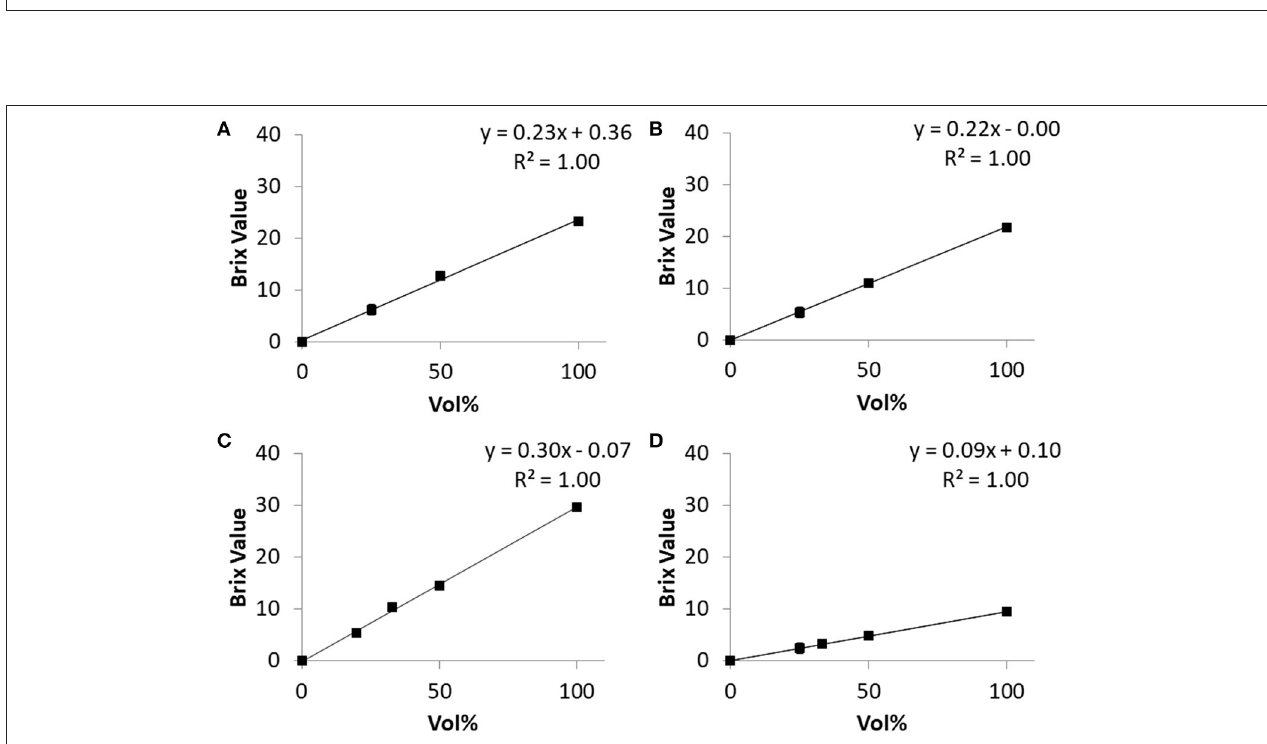
FIGURE 1 | Example for measurement and calculation of gastric residual volume. (A) Two milliliters of gastric content are aspirated via a nasogastric tube and (B) dripped at the refractometer. (C) The Brix Value is read. (D) Gastric content is diluted with 50ml water and mixed well. (E) Two milliliters are aspirated and (F) dripped at the refractometer again. (G) Gastric residual volume is now calculated using the Brix Value before and after dilution, as well as the volume of water.